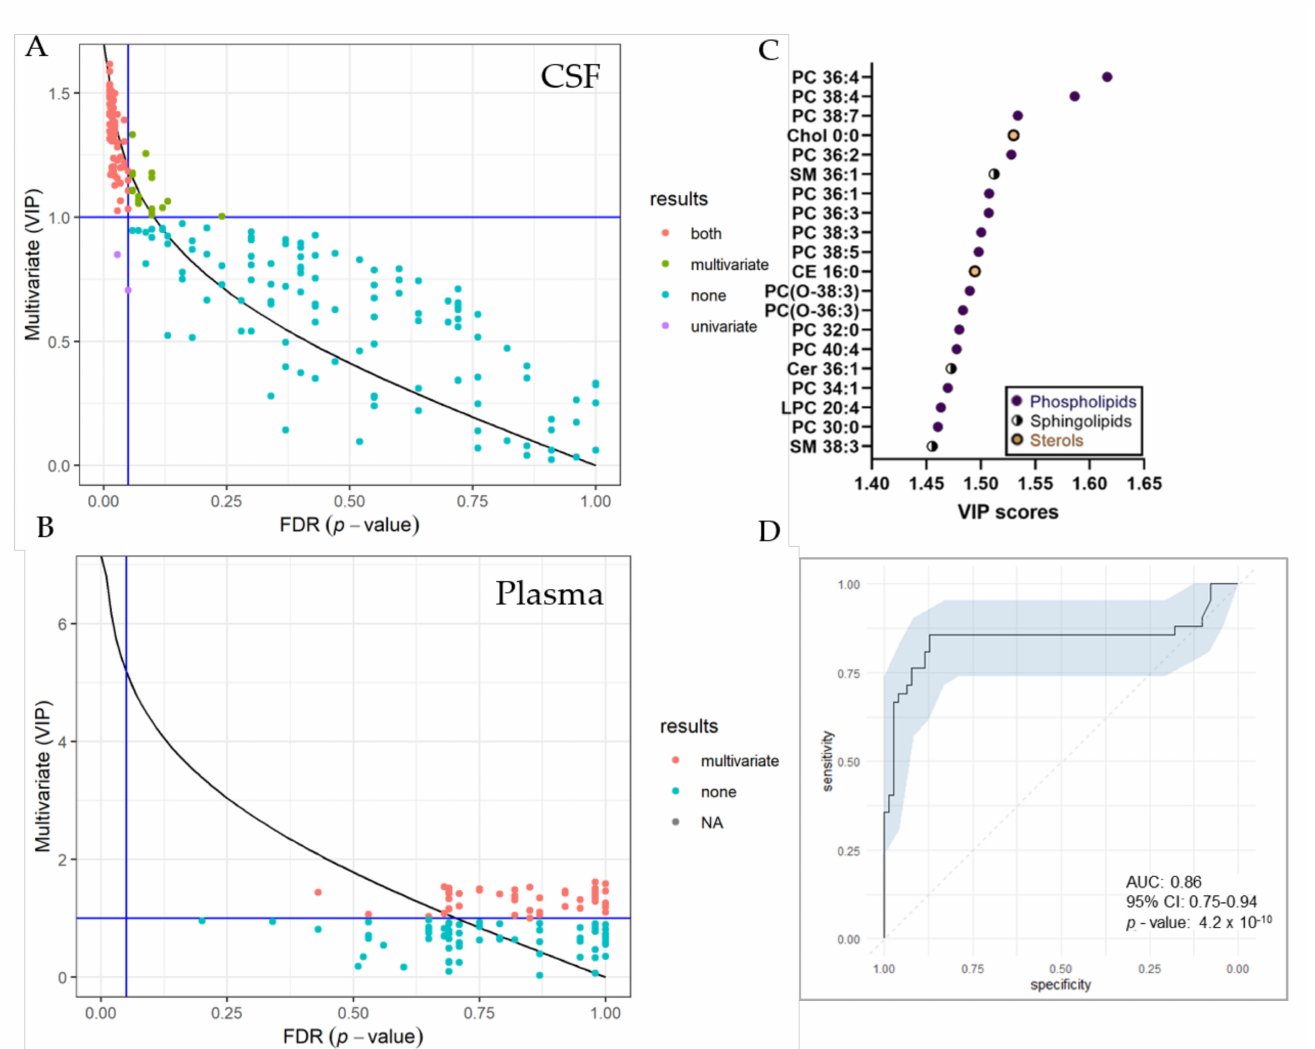
Figure 5. Selection of variable lipids by combined UVA and MVA approaches. ( A , B ) Comparison between the UVA (purple) and MVA (green) selection for CSF ( A ) and plasma ( B ) data sets. Lipids are colored according to their selection by one of the approaches or both (red). The pFDR = 0.05 (respectively, Variable Projection of Importance (VIP) = 1) threshold are displayed as a vertical (respectively, horizontal) line. Plot was created using R and the ropls package ( C ) VIP score plot of 20 most important lipid species identified in the CSF of RTT patients compared to controls. ( D ) Receiver Operating Characteristic (ROC) curve for CSF dataset, with the Area under the curve (AUC) value. The ROC curve was created from 74 significantly altered lipid species detected by both, UVA and MVA using the R packages mleval, caret and